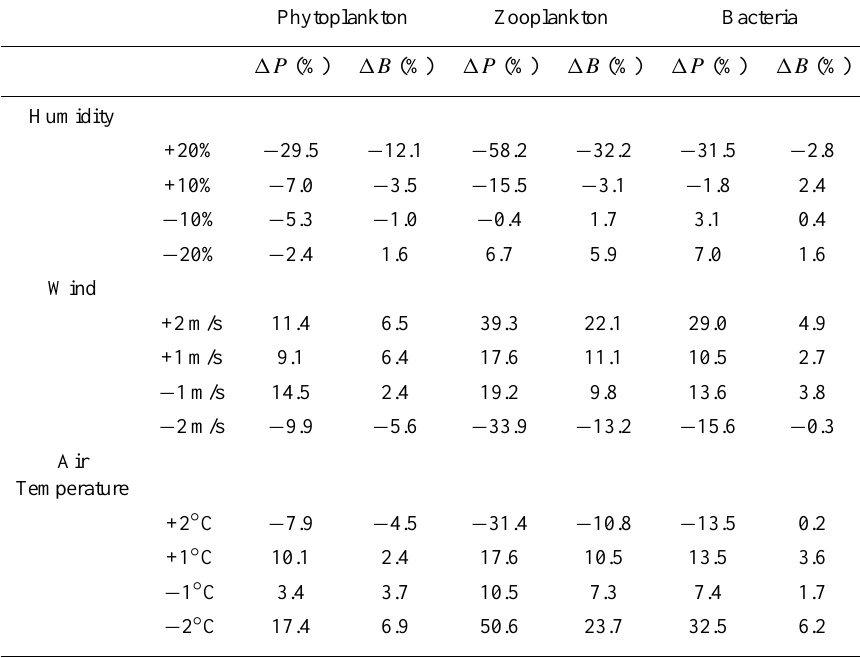
Table 6. Percent change in 160 day mean biomass ( 1B ) and production ( 1P ) for depth-integrated phytoplankton, zooplankton and bacteria with changes in forcing variables. Note the increase in relative humidity is scalar – a 20% increase in a humidity value of 50% gives 70%, not 60% Phytoplankton Zooplankton Bacteria 1P (%) 1B (%) 1P (%) 1B (%) 1P (%) 1B (%) Humidity +20% − 29.5 −